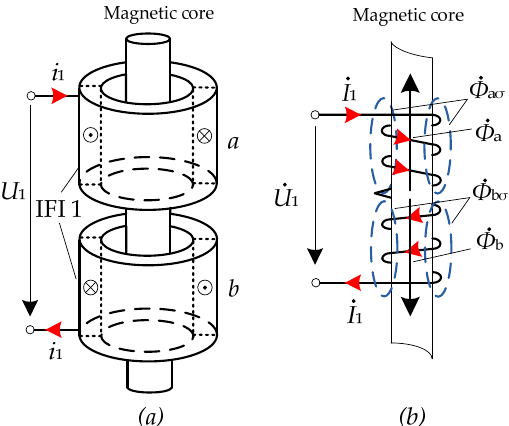
Figure 4. Schematic diagram of IFI windings: ( a ) winding structure diagram; ( b ) magnetic flux distribution diagram.